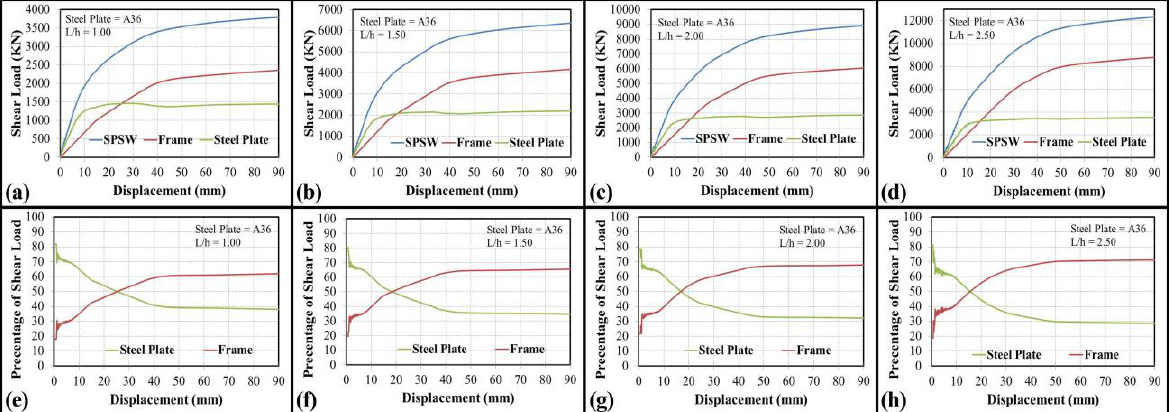
Fig. 8 . “Shear load-story drift” and “wall-frame interaction” curves of all SPSWs and moment frame using medium-yield infill plate with different spans (3m, 4.5m, 6m, and 7.5m).